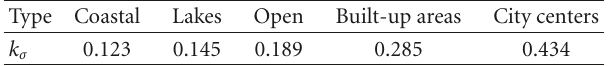
Figure 3: Typical measured signal at 29 GHz for leaved dry deciduous trees (Site 1) during low-wind speed conditions (1 to 3m/s). A sampling rate of 500 Hz was used to collect the signal.